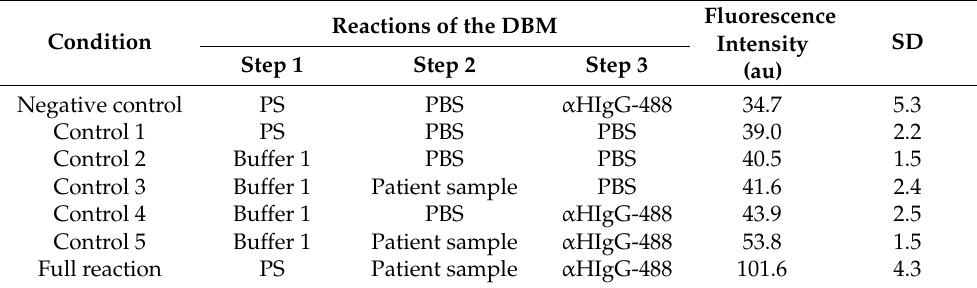
Table 1. Non-specific binding